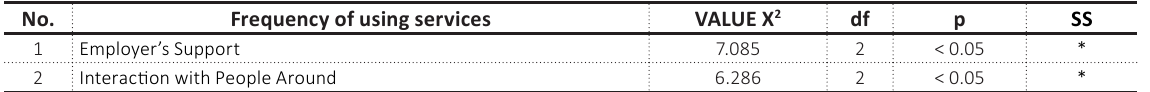
Table 3. Frequency of using services